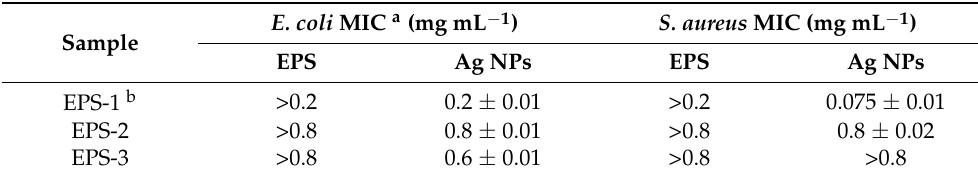
Table 4. The antibacterial activity of Cs-HK1 EPS fractions and corresponding EPS-coated Ag NPs after incubation at 37 ◦ C for 12 h.